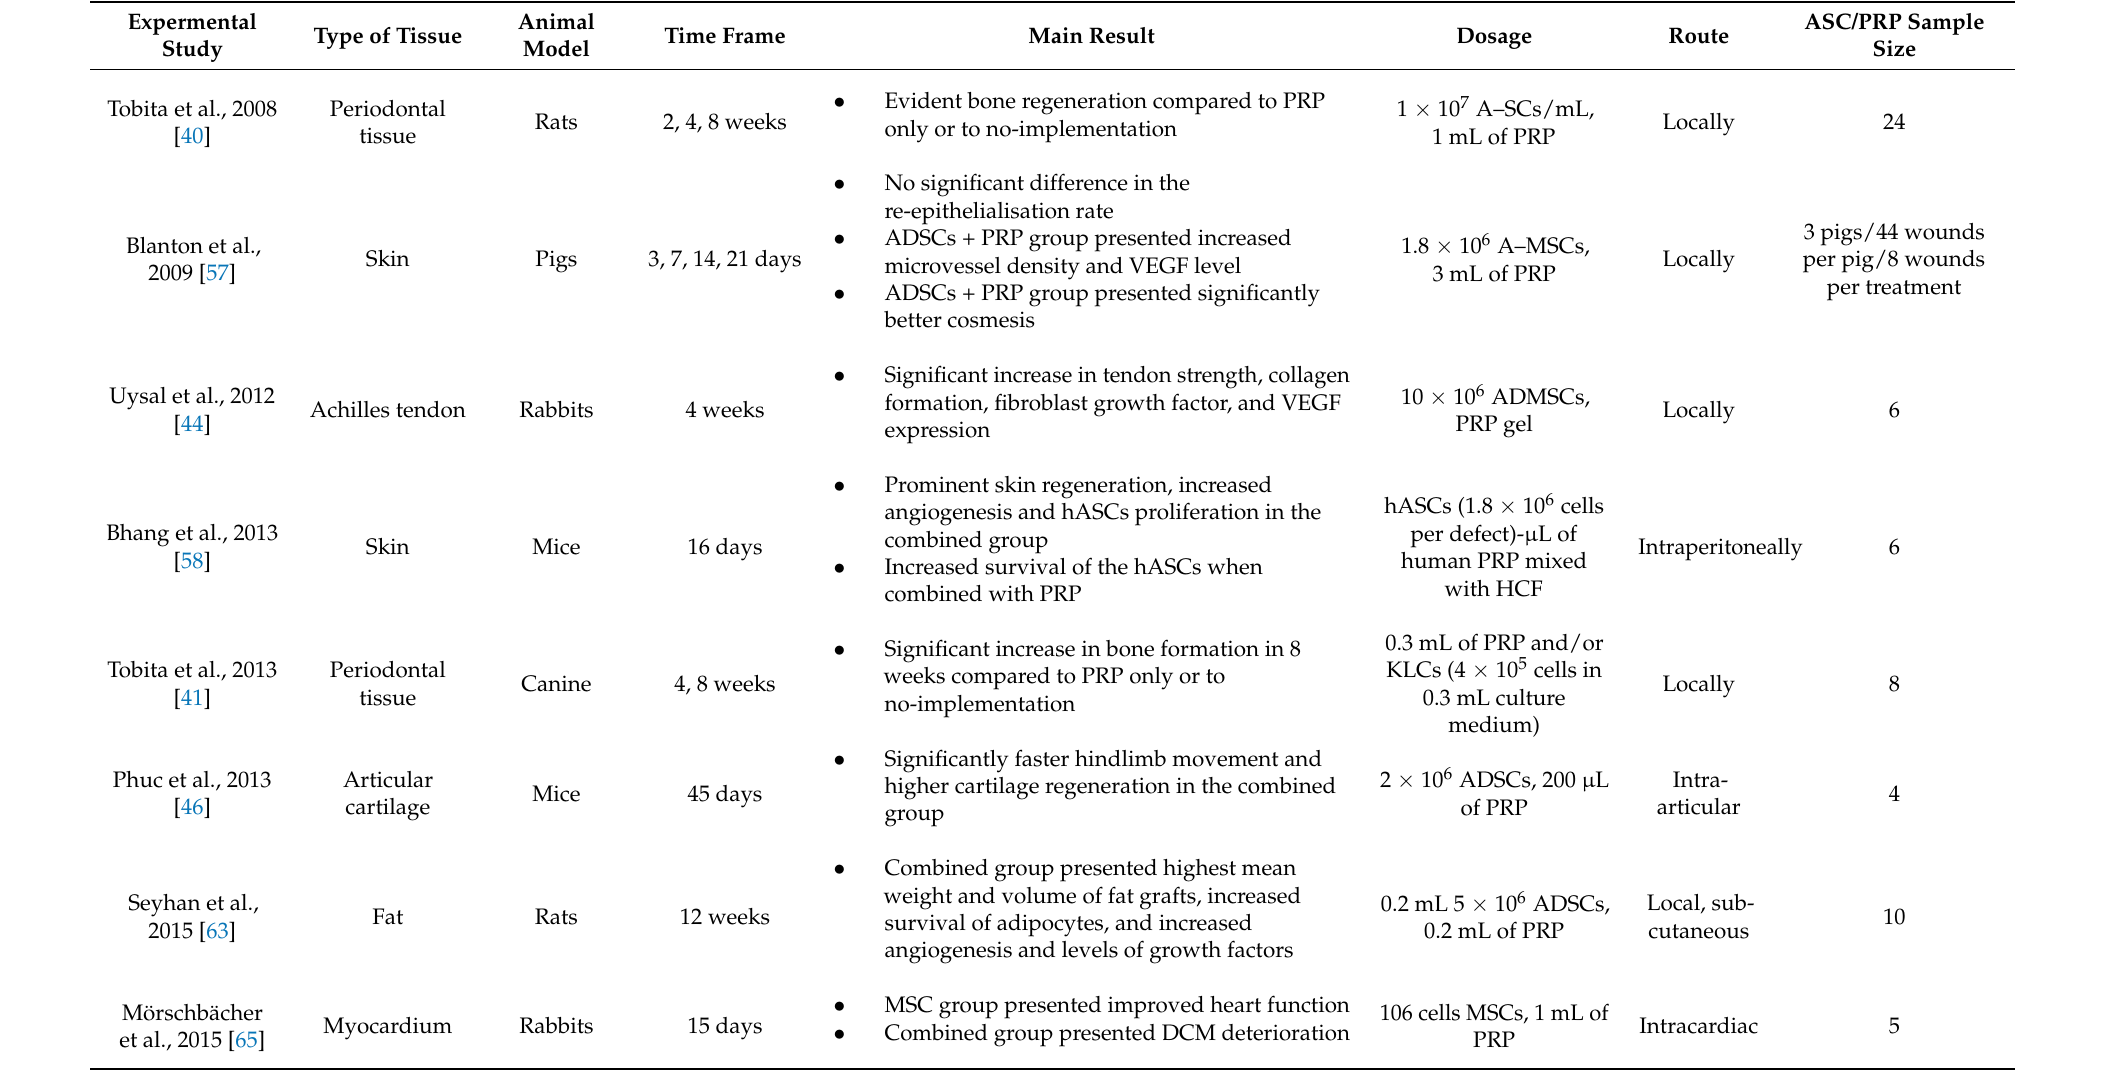
Table 2. Experimental studies on the combined use of PRP and